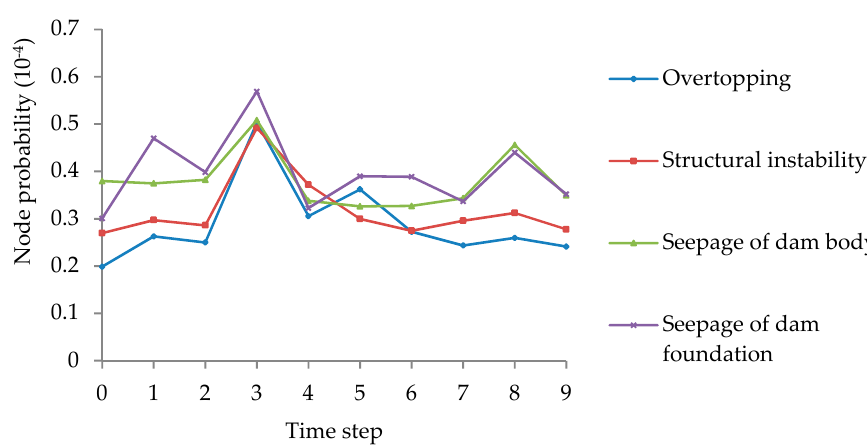
Figure 7. Time series variation curves of the probability of risk events.